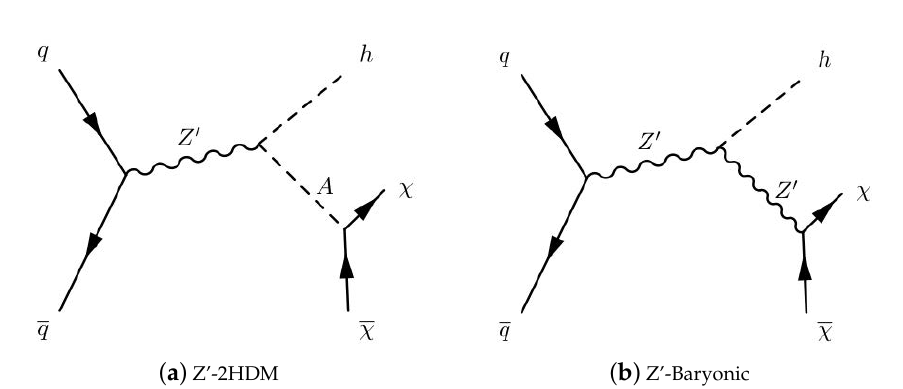
Figure 7. Simplified models inspected by mono-Higgs analyses. On the ( a ), the Z’-2HDMmodel, and on the ( b ), the Z’-baryonic